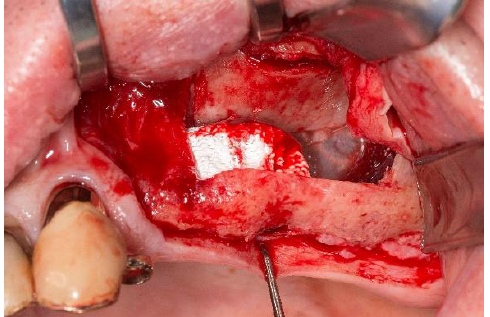
Figure 3. The intra-operative situs after fixation of the scaffold in the left maxillary sinus with a fixation screw on the crestal bone. The access bone lid is deflected into the maxillary sinus. After a healing period of nine months, the re-entry for implant insertion was performed in local anesthesia. After the bilateral crestal incision and the elevation of a mucoperiosteal flap, the micro screws could be removed without problems. In order to obtain a tissue biopsy for histological analysis of the augmented site, the implant cavities in regions 16